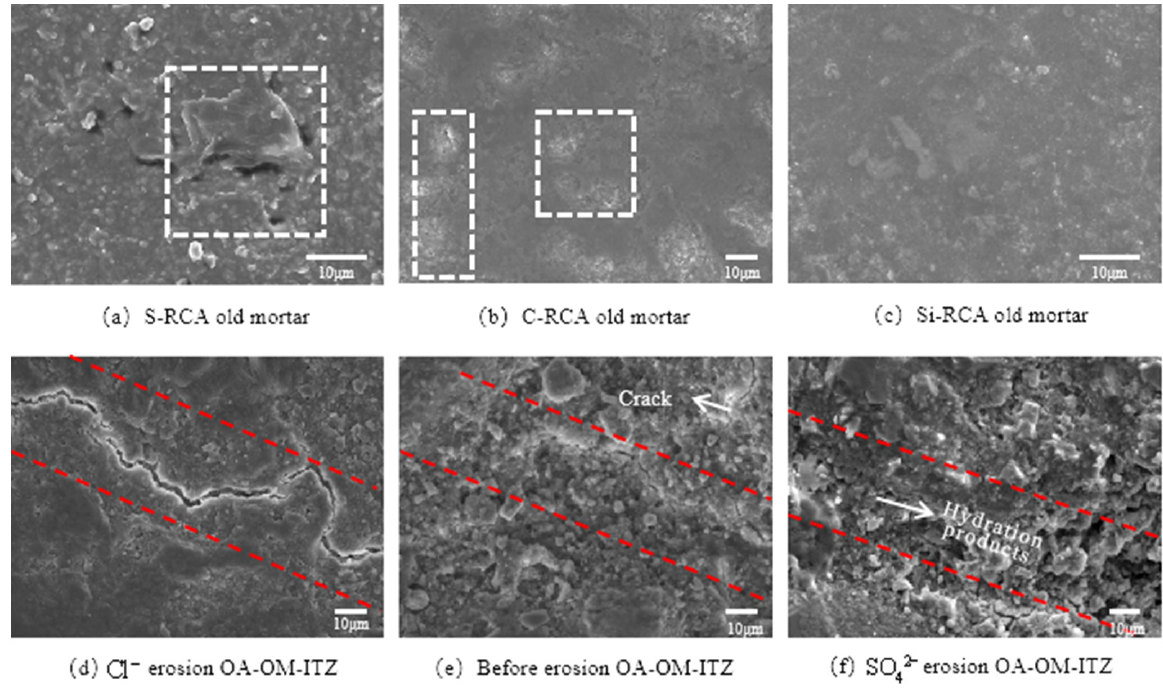
Figure 11. Scanning electron microscopy (SEM) micromorphology.